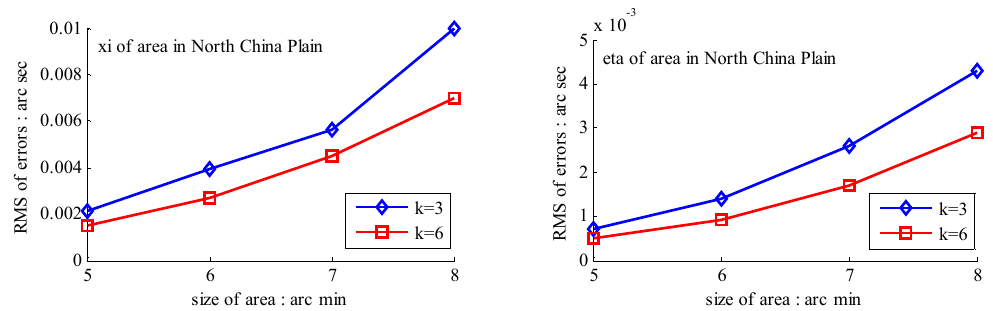
Figure 9. The RMS of fitted errors for different size of area, when k = 3 and 6.